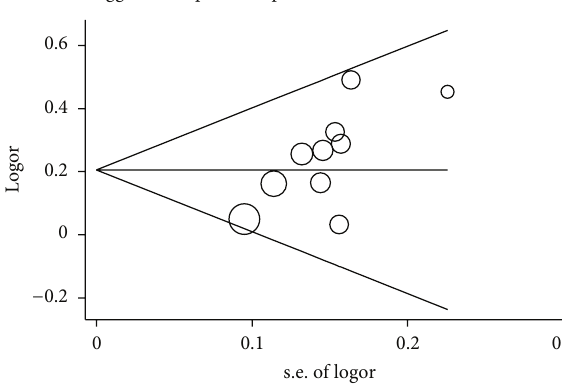
Figure 7: Funnel plot analysis to detect publication bias for TC + CC versus TT model of IL-17F rs763780T > C polymorphism. Each point represents a separate